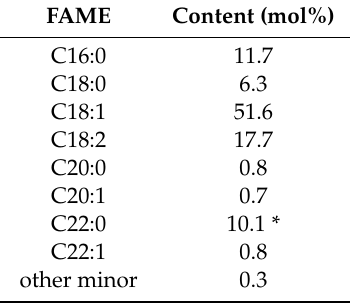
Table 1. Lipidic composition of the karanja fatty acid methyl esters (FAME) mixture used in the present